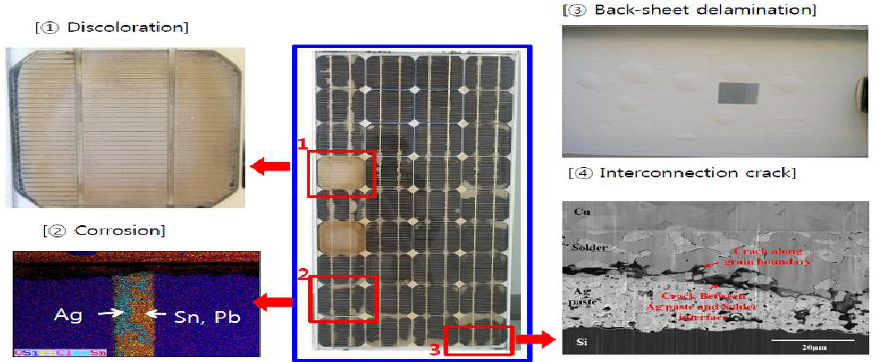
Figure 1. Aging phenomena in PV modules.